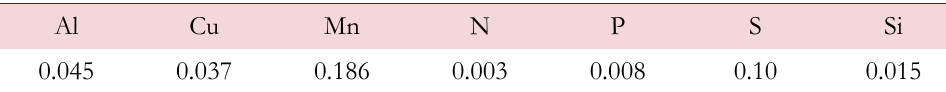
Table 1: Chemical composition of steel 08U (%).